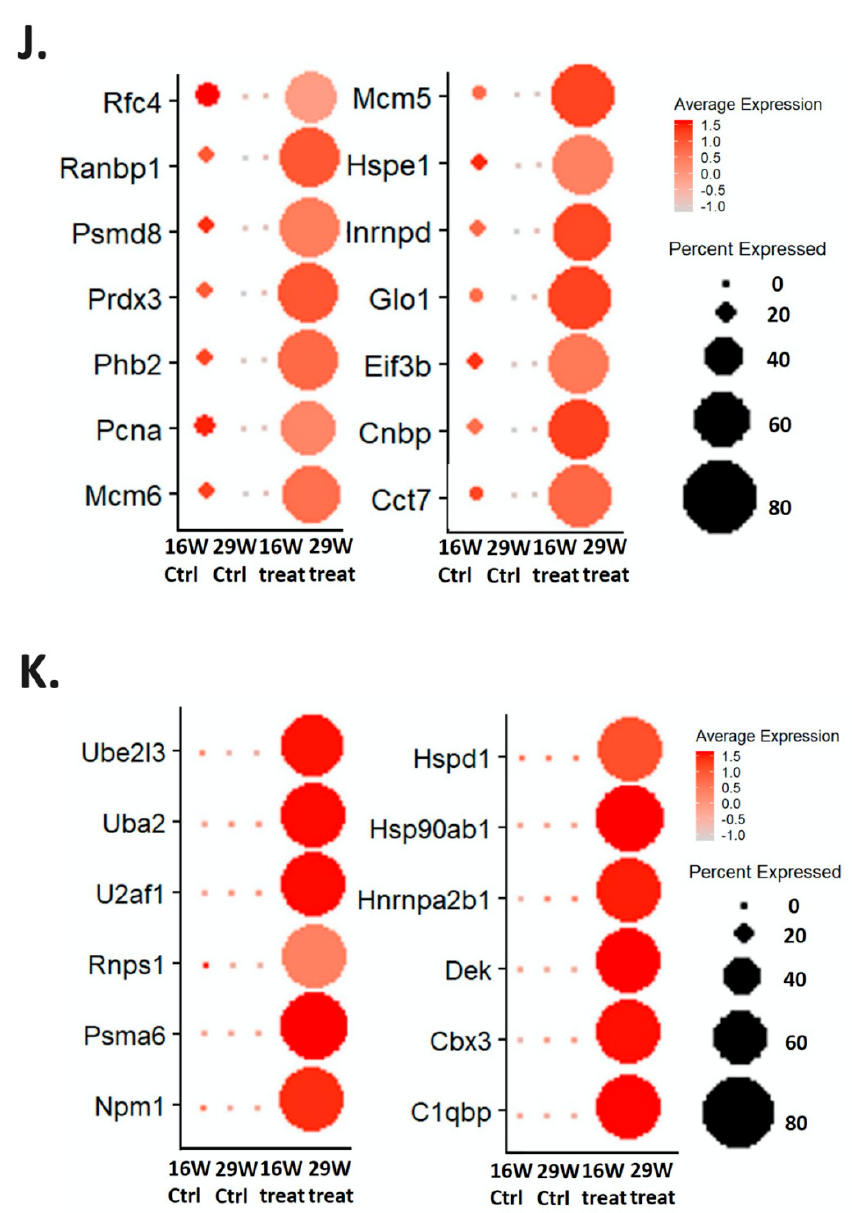
Figure 3. Comparison of the compositions of cell subtypes between the 16- and 29-week control and experimental groups. ( A ) Proportion of the 17 cell subtypes with respect to the total cell composition presented as a pie chart. ( B ) Comparison of the proportion of the seventh and ninth cell subtypes in the four major groups. ( C ) Line graph comparing the proportions of the seventh and ninth cell subtypes in the four major groups. The proportion increased with increasing treatment duration in in the experimental group. ( D – F ) Gene function enrichment analysis of the seventh cell subtype. ( D ) Line chart indicating the three most significant pathways involved in the increase in gene expression in the 16- and 29-week experimental groups. ( E ) Line chart showing the three most significant pathways involved in the decline in gene expression in the 16- and 29-week experimental groups. ( F ) Bar graph of the normalized enrichment scores (NESs) and p values of these three paths (* p < 0.05; ** p < 0.01; *** p < 0.001). ( G – I ) Gene function enrichment analysis of the ninth cell subtype. ( G ) Line chart indicating the three most significant pathways involved in the increase in gene expression in the 16- and 29-week experimental groups. ( H ) Line chart showing three most significant pathways involved in the decline in gene expression in the 16- and 29-week experimental groups. ( I ) Bar graph displaying the calculated NESs and p values of these three paths (* p < 0.05; ** p < 0.01; *** p < 0.001). ( J ) Dot diagram of genes involved in the MYC_targets_v1 pathway in the seventh subtype. The average gene expression level and the percentage of cells in the four groups are indicated by the color